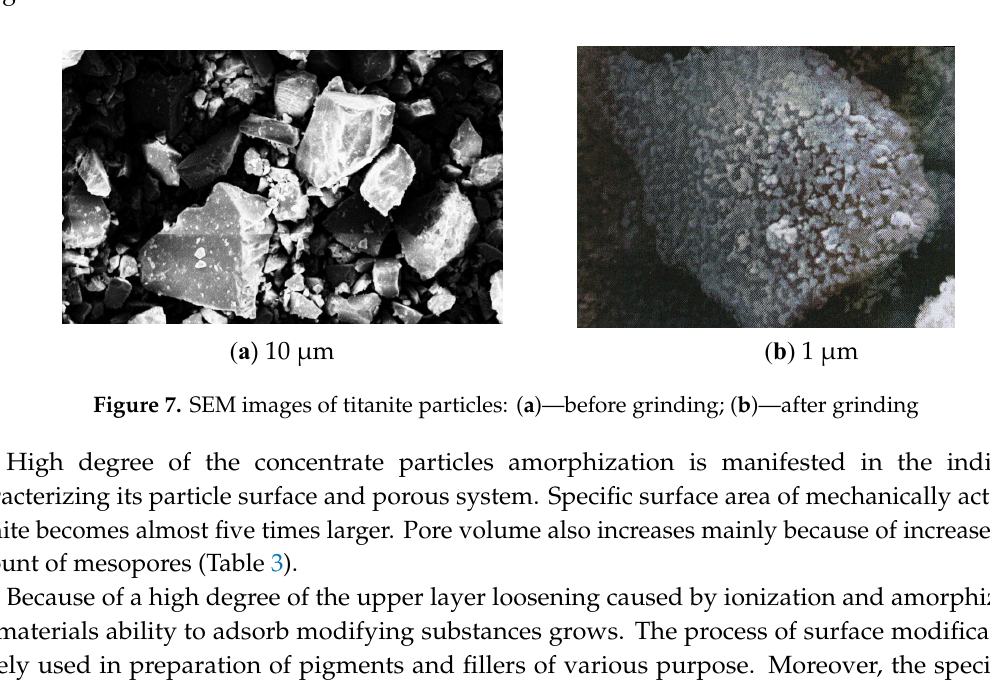
Table 3. Surface properties of original and ultra-ground concentrate.